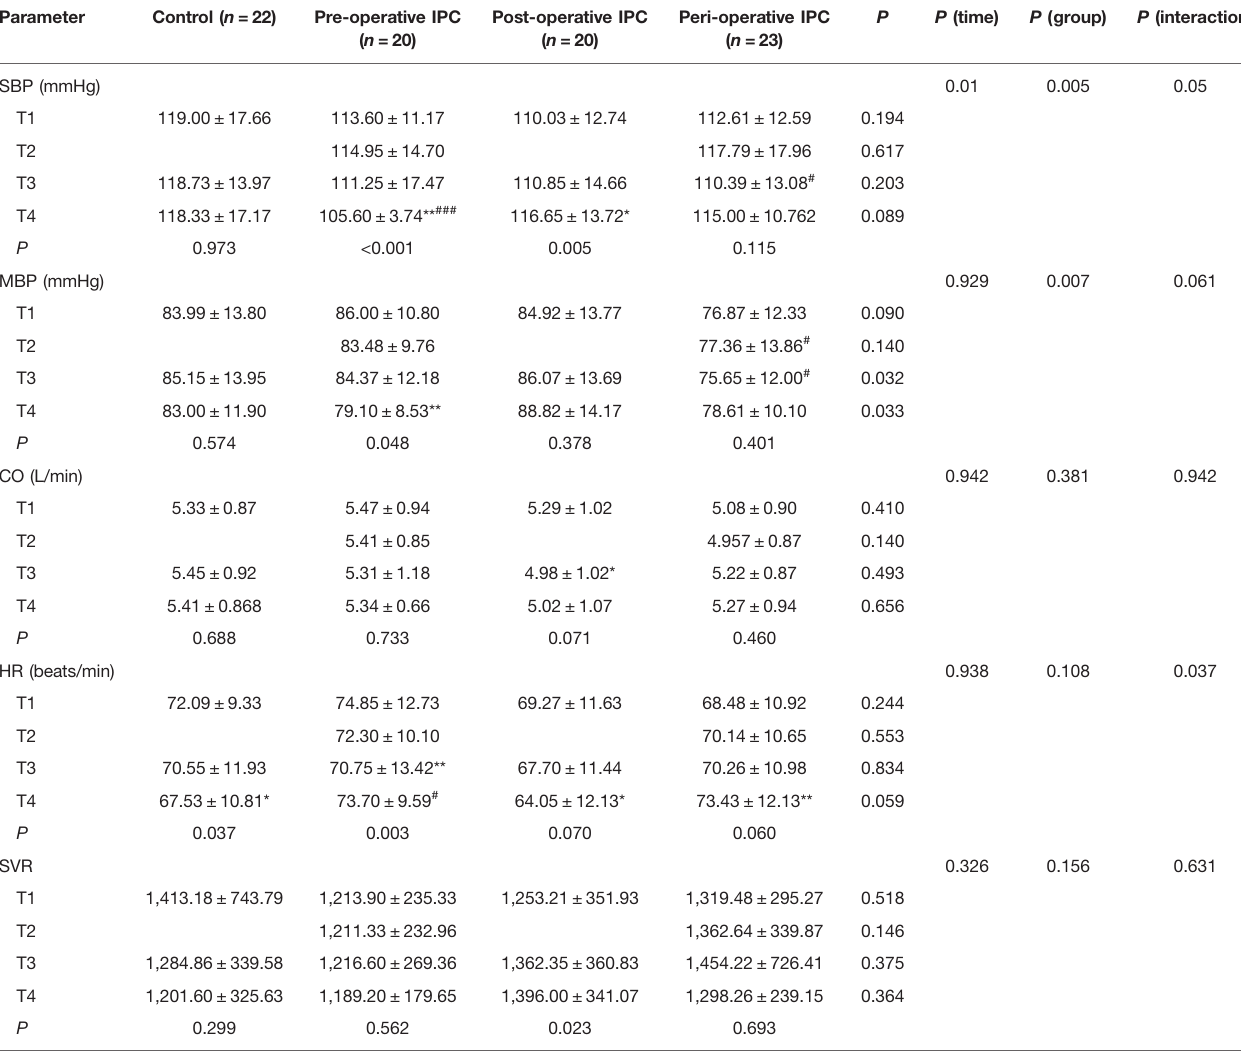
TABLE 2 | Changes in hemodynamic parameters in the four groups.